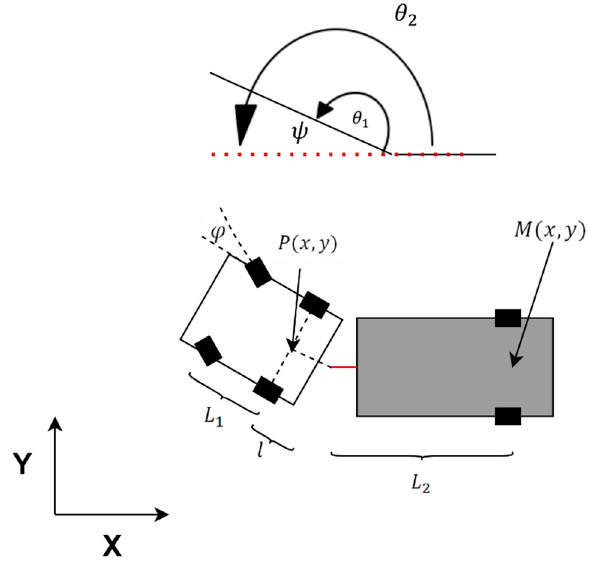
Figure 1. Tractor–Trailer System model.